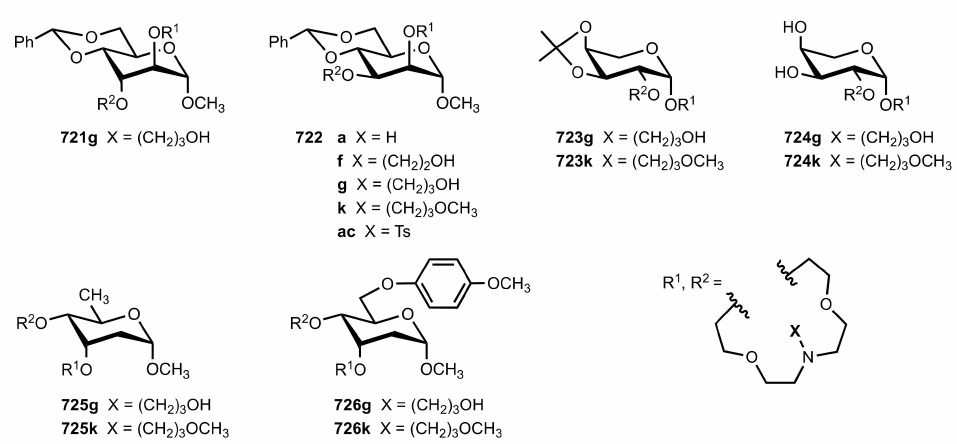
Figure 47. Aza-crown ether prepared by Bak ó and co-workers from various glycosides. Another series of aza-crown ethers, featuring the nitrogen atom directly linked to the sugar unit, was prepared by regioselective epoxide opening of 569 with ethanolamine followed by cyclisation with tri- or tetraethylene glycol ditosylate to afford the altrose-based crown-amines 727 and 728 (Scheme 182)